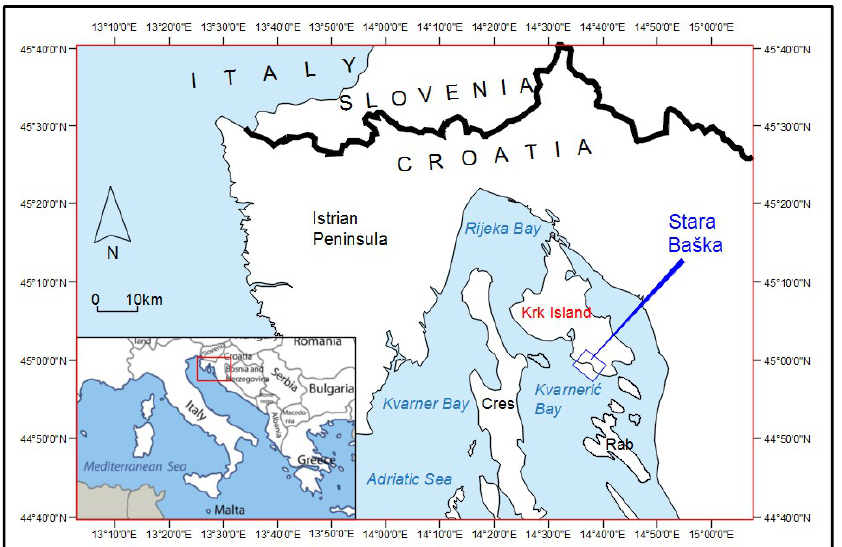
Figure 1. Location of the research area around Stara Baška on Krk Island.